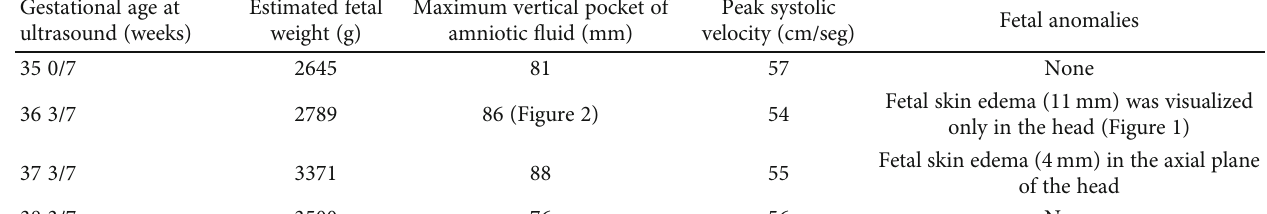
Table 1: In-person follow-up of the pregnant woman after the PCR for SARS-CoV-2 was negative. Gestational age at